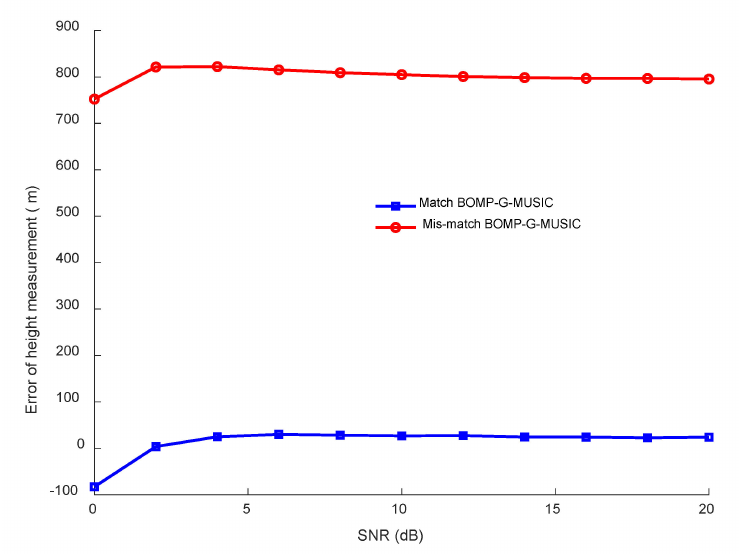
Figure 8. Height estimation error of terrain mismatch and